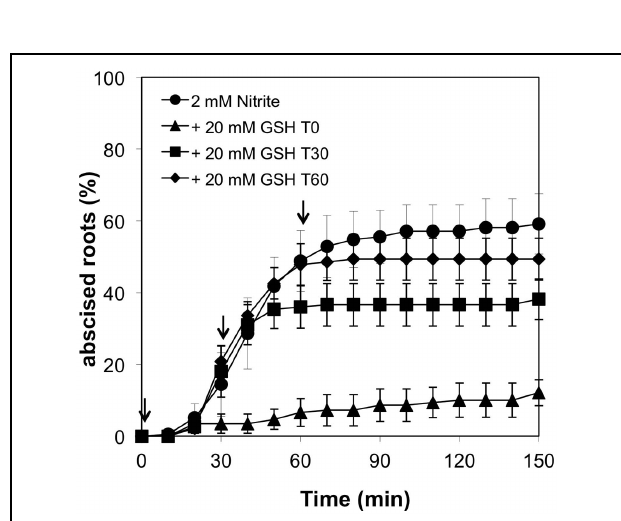
FIGURE 6 | Effect of glutathione (GSH) on nitrite-induced root abscission. 20 mM GSH was added at various time points (arrows) following addition of 2 mM nitrite (means ± SE, n =